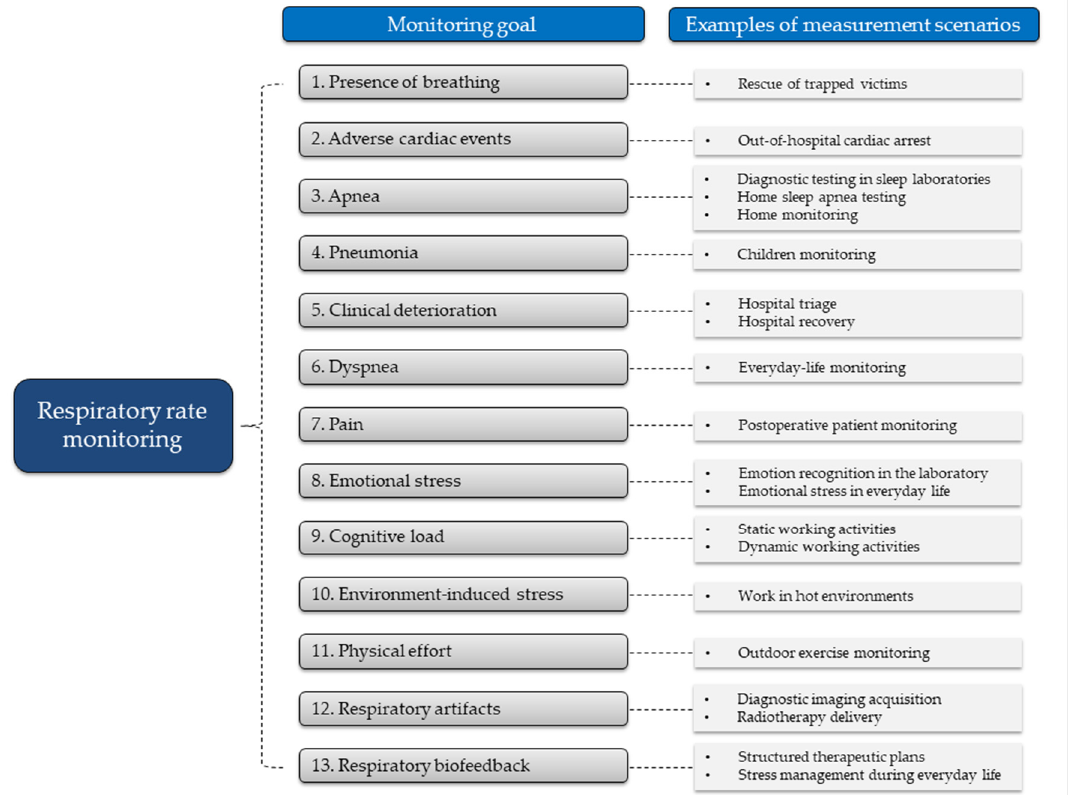
Figure 1. Schematic representation of the monitoring goals described in this review and related examples of specific measurement scenarios.